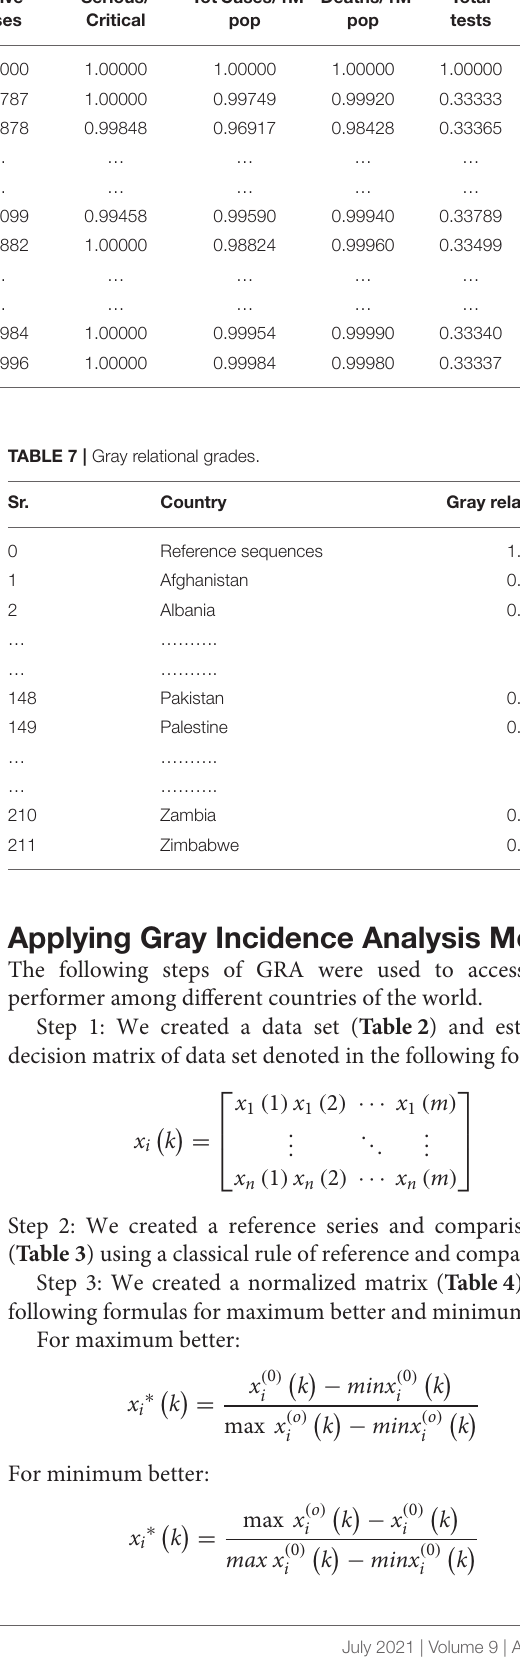
TABLE 6 | Gray relational co-efficient. Sr.